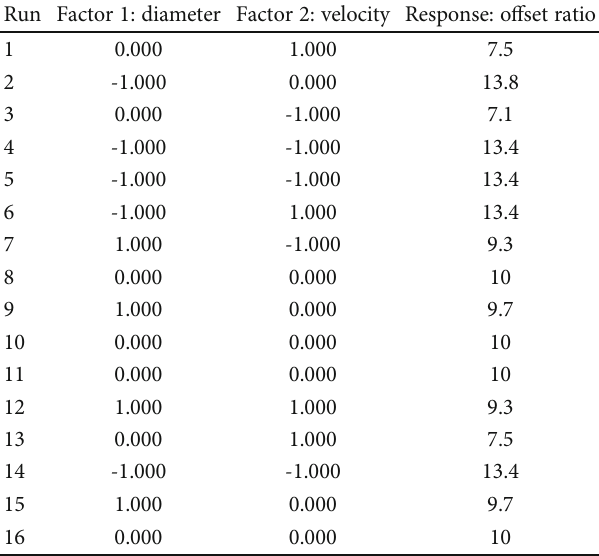
Figure 10: O ff set ratio vs. velocity.